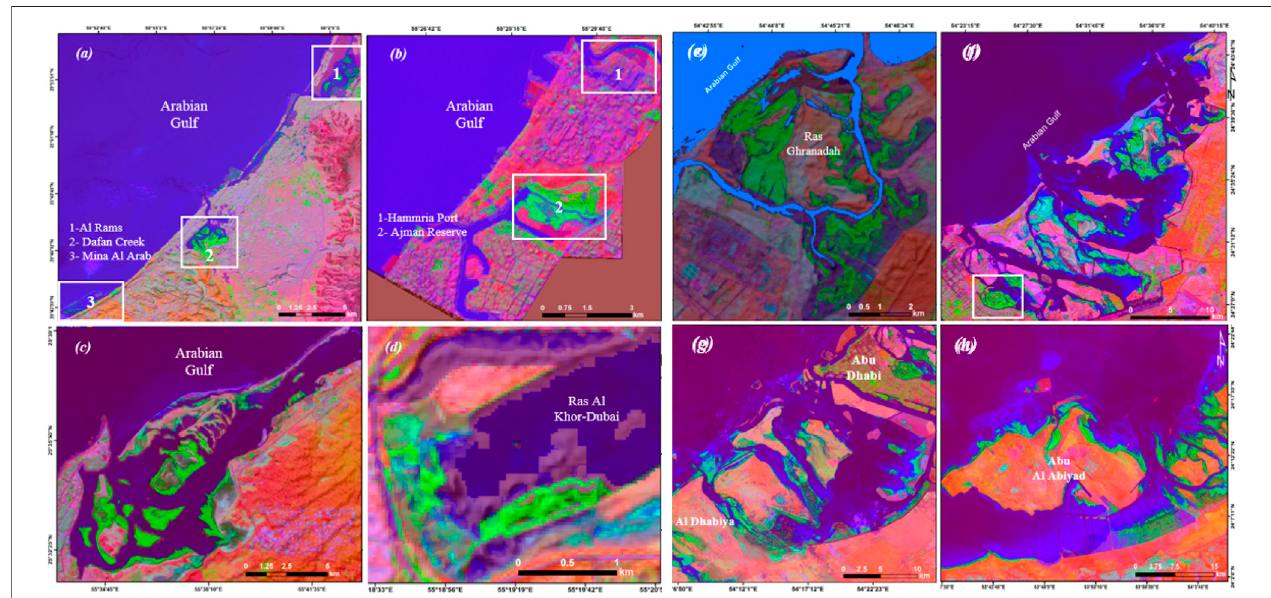
FIGURE2| RGB651bandcombinationofLandsat8imagezoomsenhancedbyapplyingcontraststarchedshowingthespatialdistributionoftheUAEmangroves in Ras Al Khaimah (A) , Ajman – Al Hamriya (B) , Umm AlQuwain (C) , Ras AlKhor of Dubai (D) , Ras Ghanada (E) , Abu Dhabi – AlSaadiyat – Shelilah – Hanioura strip (F) , Abu Dhabi – Al Dhabiya (G) , and Al Dhabiya – Abu Al Abyad (H) . White square highlights the location of Abu Dhabi National Park.